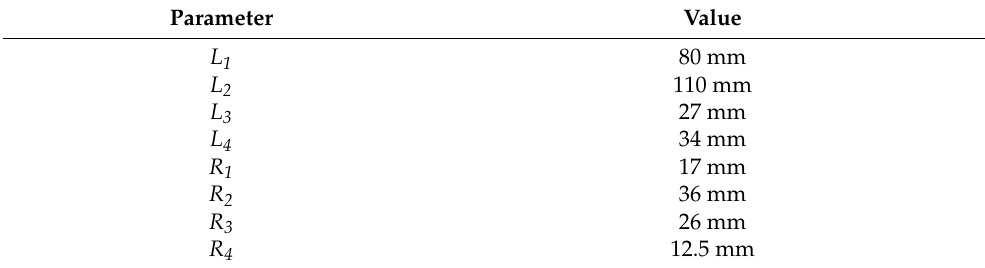
Table 3. Parameters of the SC model.